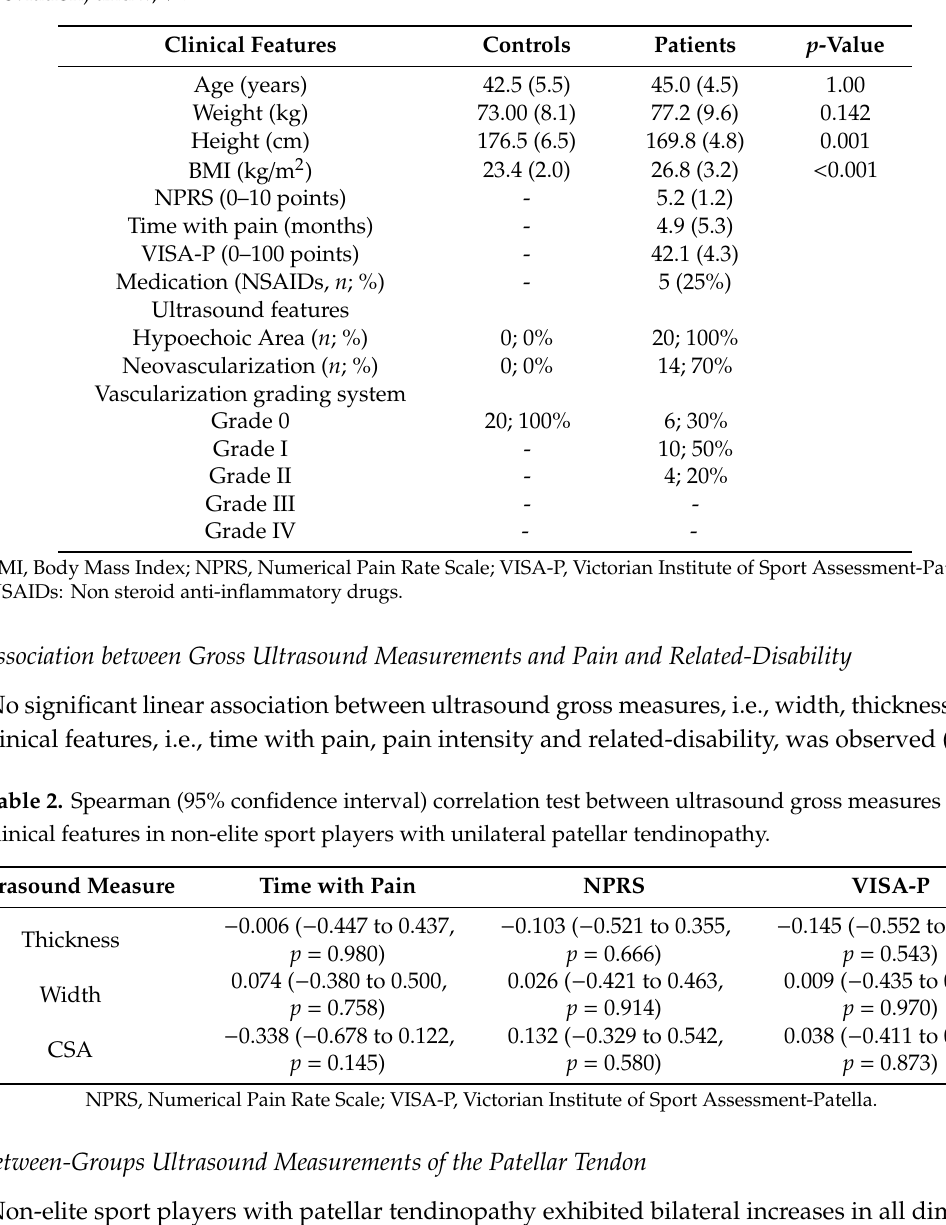
Table 1. Anthropometry and clinical features of the sample. Values are presented as Mean (Standard Deviation) and n ; %.